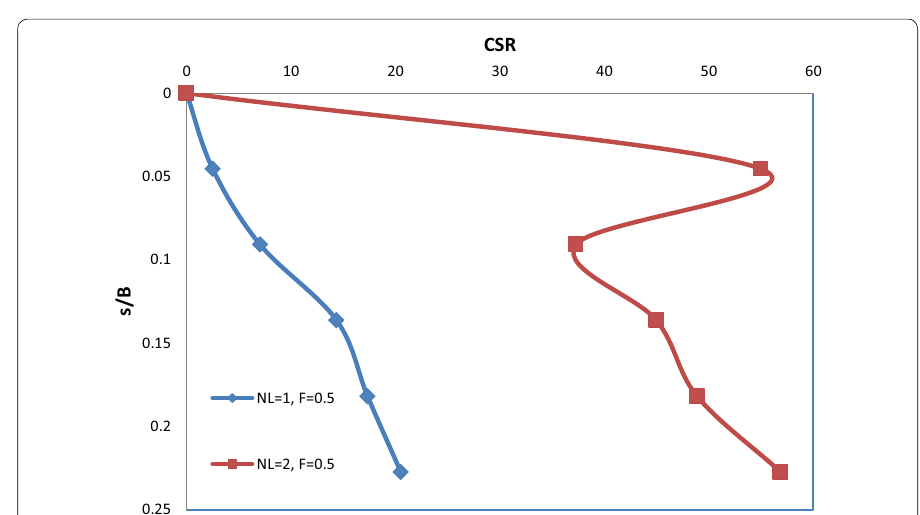
Fig. 9 CSR with s/B for different layer configuration under F